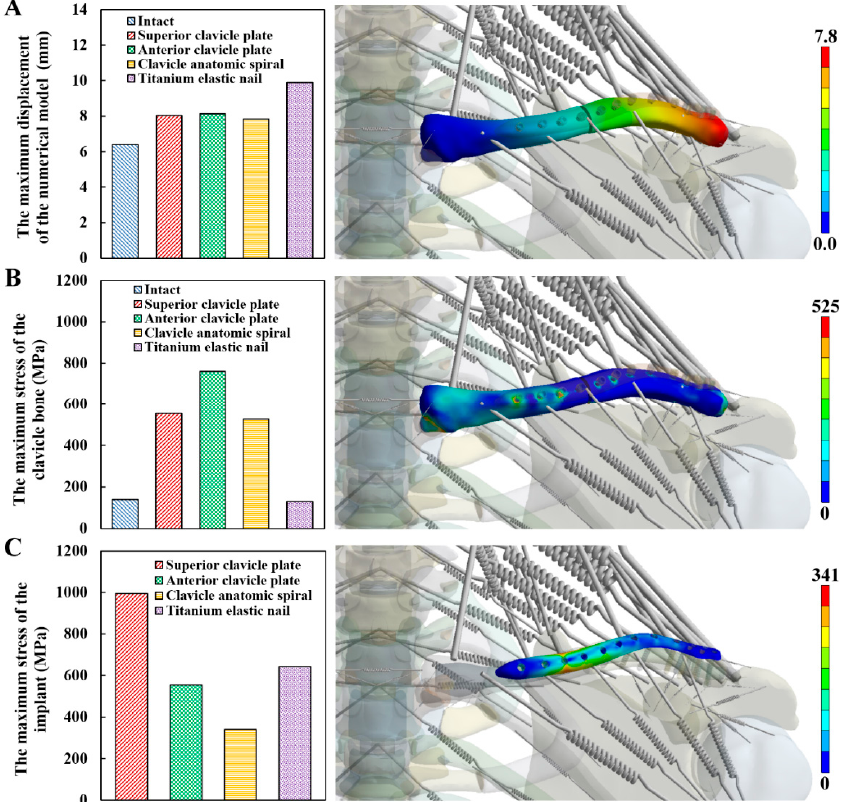
Figure 6. Results of complete human upper-body models: ( A ) maximum displacement, ( B ) clavicle bone stress, and ( C ) implant stress.